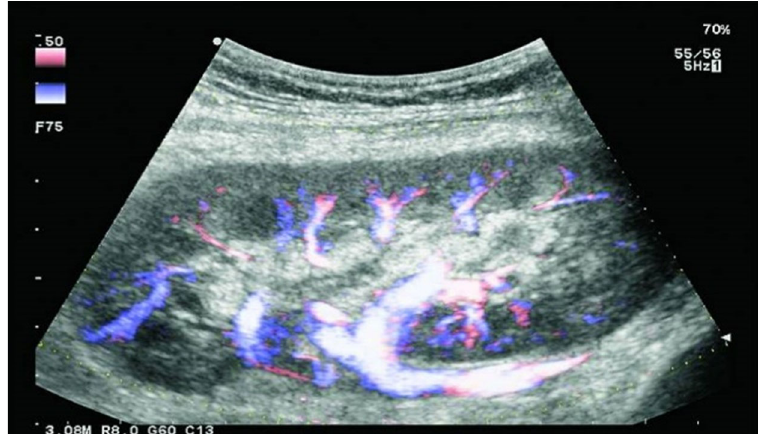
Figure 6. Renal ultrasound five years after